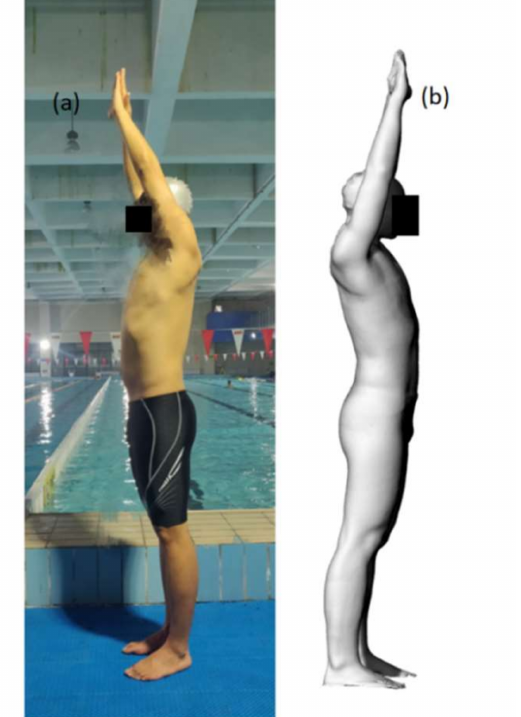
Figure 1. ( a ) Swimmer. ( b ) Surface reconstruction produced from a laser